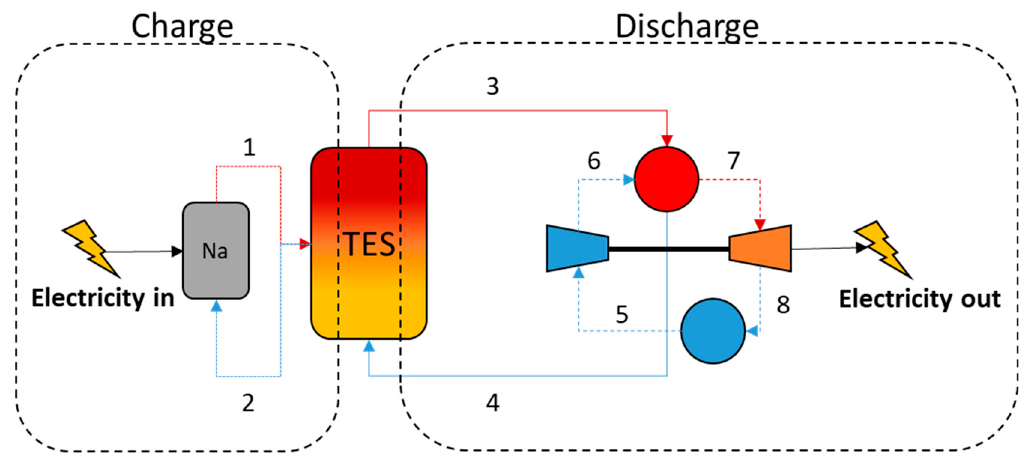
Figure 3. Outline of a Cascaded PCM TES Carnot Battery with a sCO 2 Brayton Cycle. Table 2. Operating Conditions of Analysed Carnot